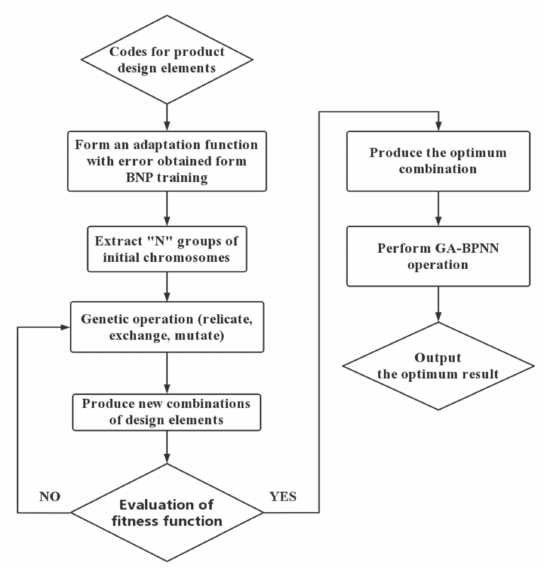
Figure 11. GA used to optimize BPNN model flow